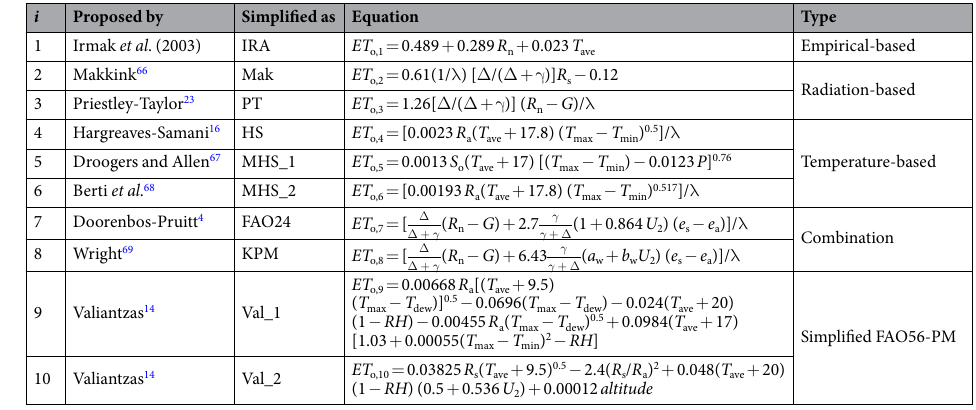
Table 1. Equations of ET o,i estimated with the selected 10